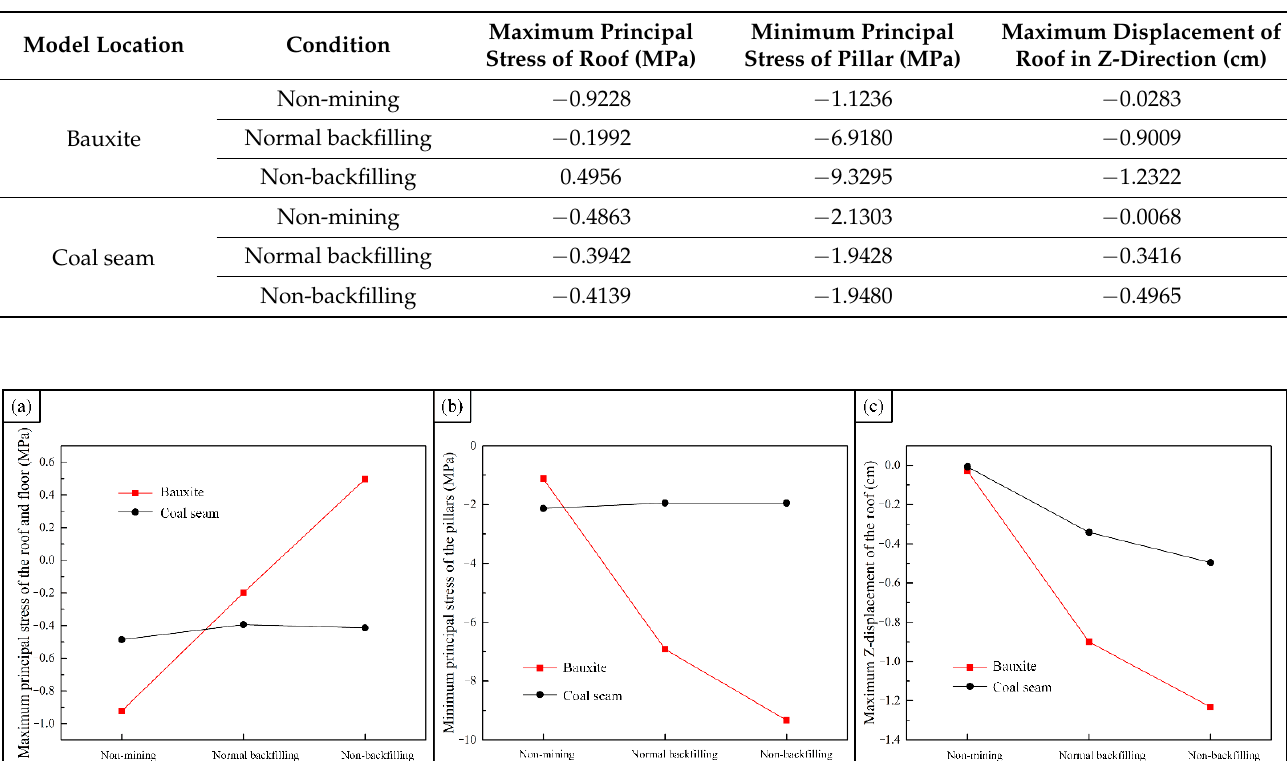
Figure 9. Distribution of plastic zone: ( a ) non-mining condition; ( b ) normal backfilling condition; ( c ) non-backfilling condition. Table 4. Extreme values of principal stress and displacement under different mining conditions.